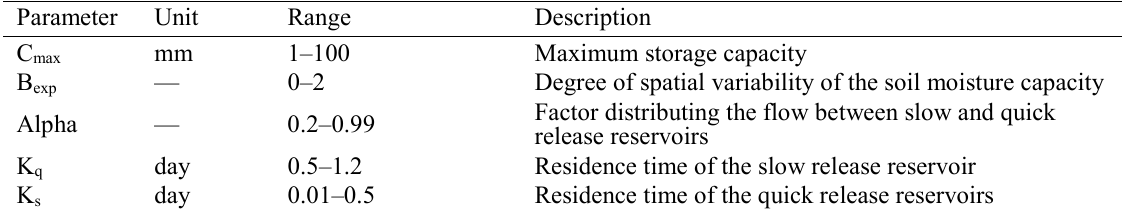
Table 1 Description of the HYMOD